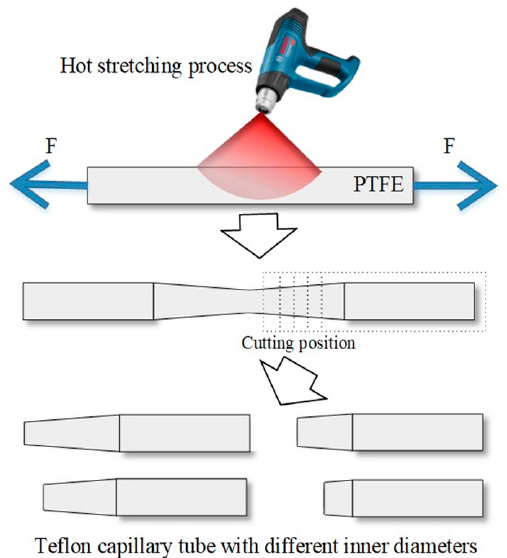
Figure A1. Process diagram of Teflon capillary tube.